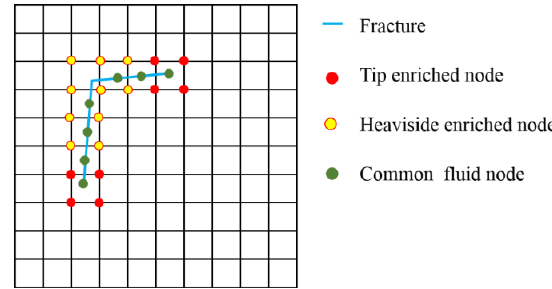
Figure 1. Schematic of enrich nodes and fluid nodes.